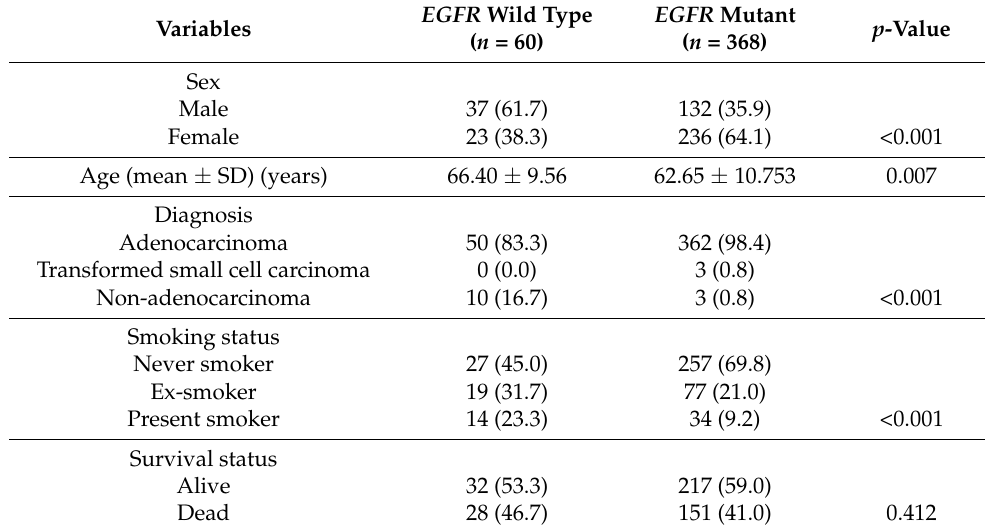
Table 1. Demographic parameters of patients.